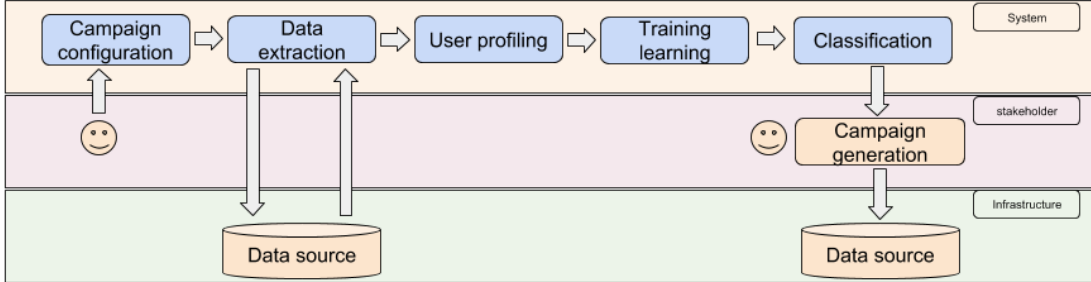
Figure 5. System architecture. Most of the campaign generation process is fully autonomous. The stakeholder only must configure the campaign (i.e., the type of customers) and to select the top N customers desired to be included in the campaign. Our system (in blue) autonomously extracts the information needed, generates the customer profiles, builds a tuned model and assigns the final score to each